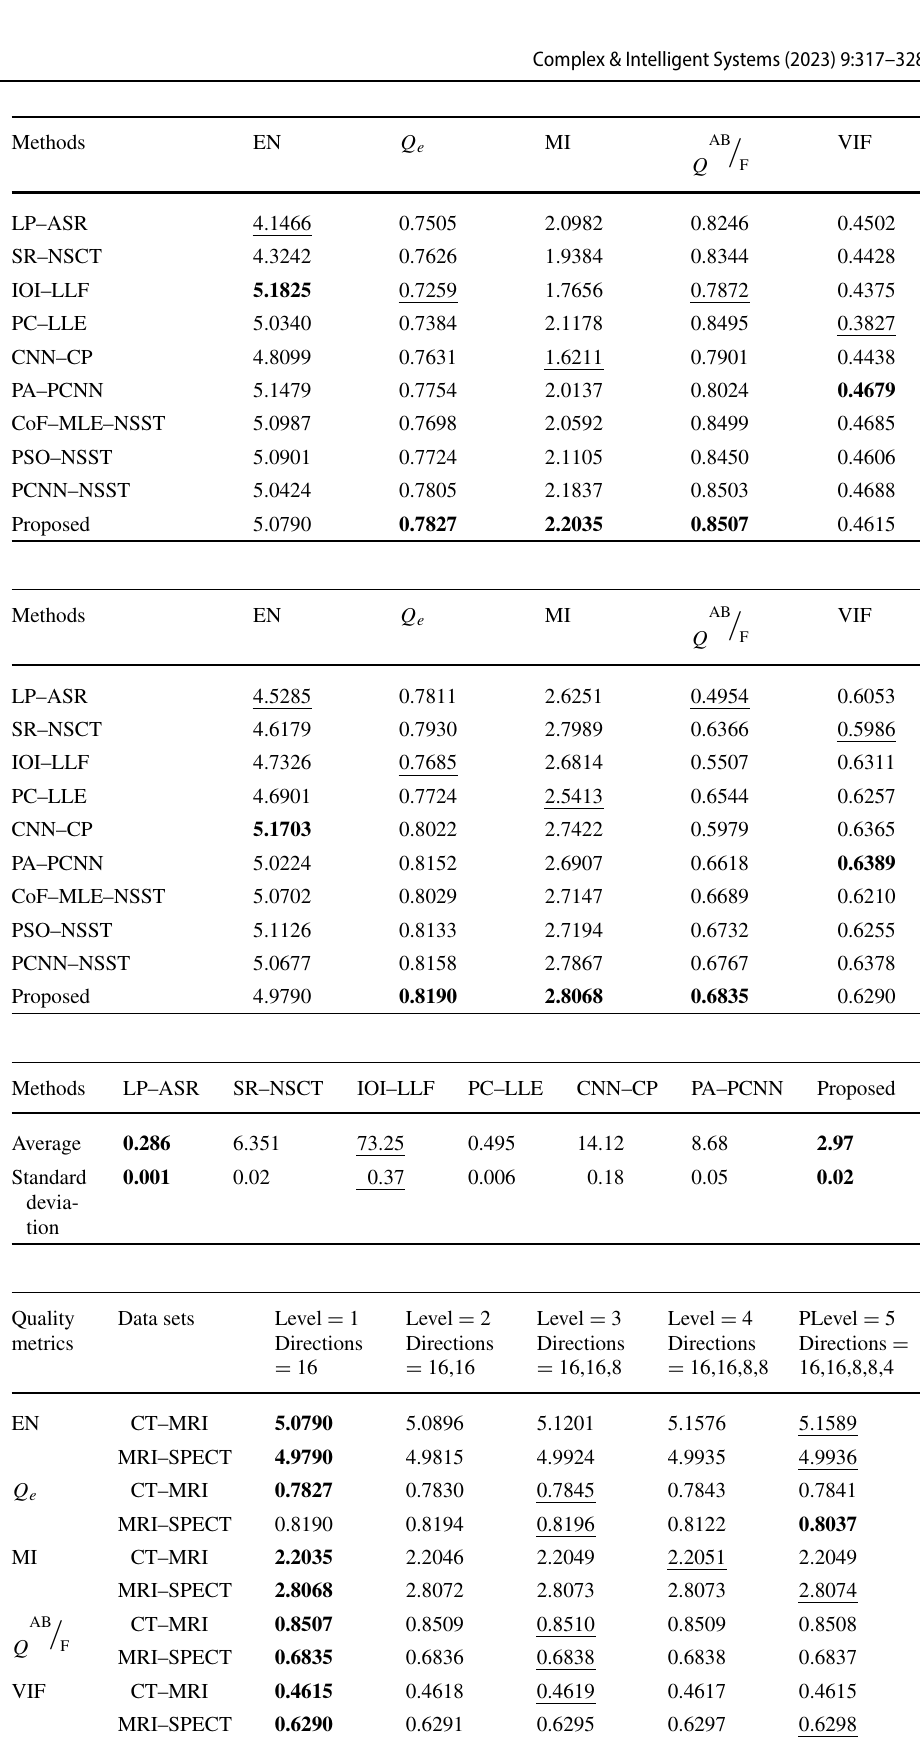
Table 1 Objective evaluation of CT–MRI fusion images